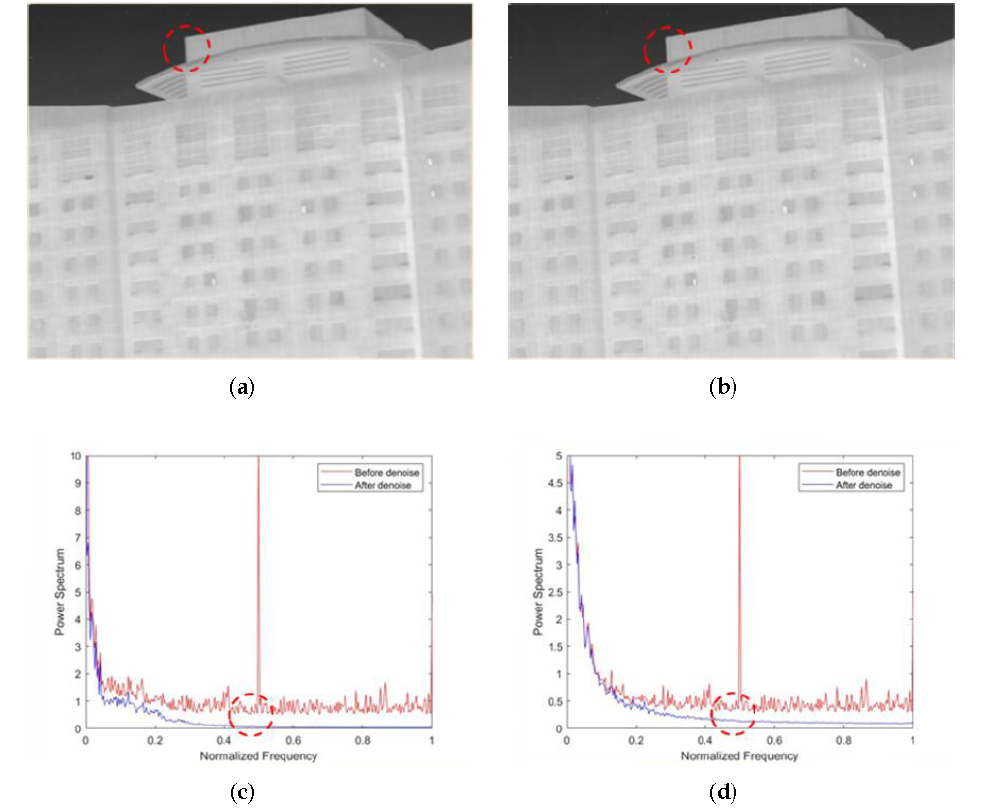
Figure 9. Denoising effects of ablation experiment on an image of a single building: ( a ) non-AEPO; ( b ) our approach; ( c ) non-AEPO; ( d ) our